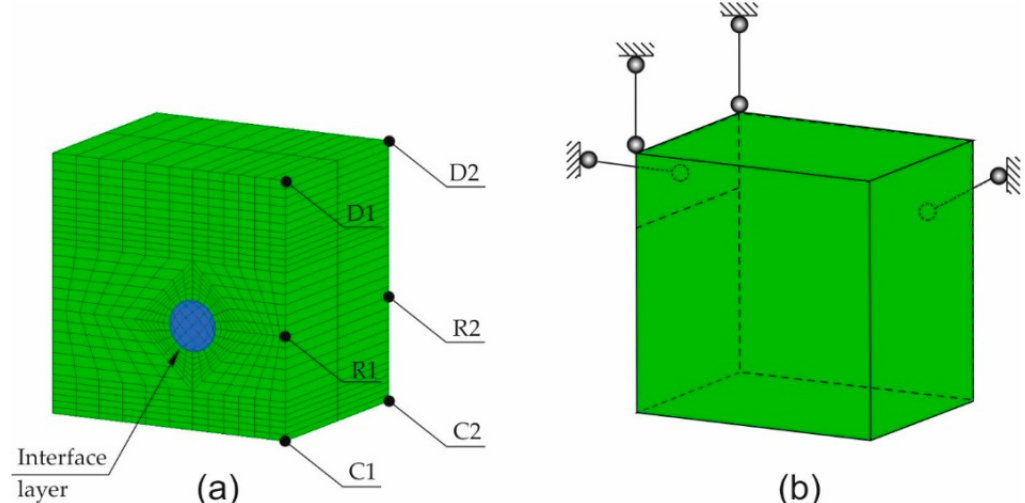
Figure 8. Static diagram of the sample adopted for numerical calculations: ( a ) finite element mesh, ( b ) boundary condition applied to the test sample–description in the text.